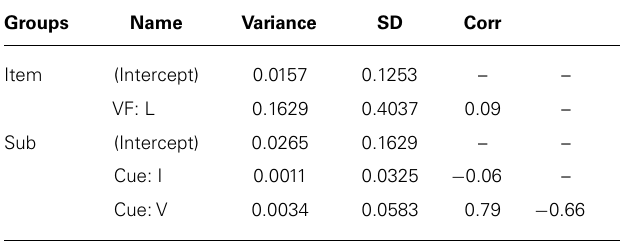
Table 2 | Random effects of the final